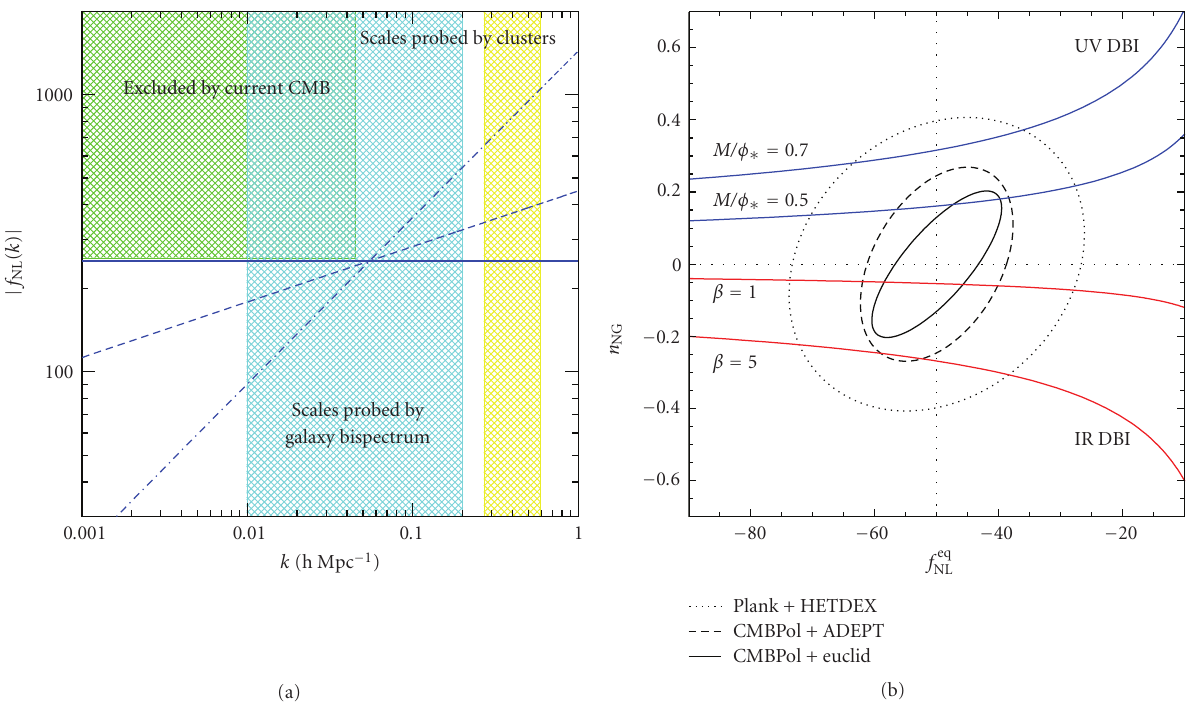
Figure 23: (a) Range of scales probed by di ff erent observables compared with f NL ( k ) for di ff erent values of the running parameter n N G , from the study by Lo Verde et al. in [137]. (b) Predictions of DBI models showing the peculiar relation between the amplitude f eq . running n N G for di ff erent values of the parameters of the inflaton Lagrangian. The figure includes the Fisher matrix forecasts for combined CMB and galaxy bispectrum measurements assuming a fiducial f eq . further